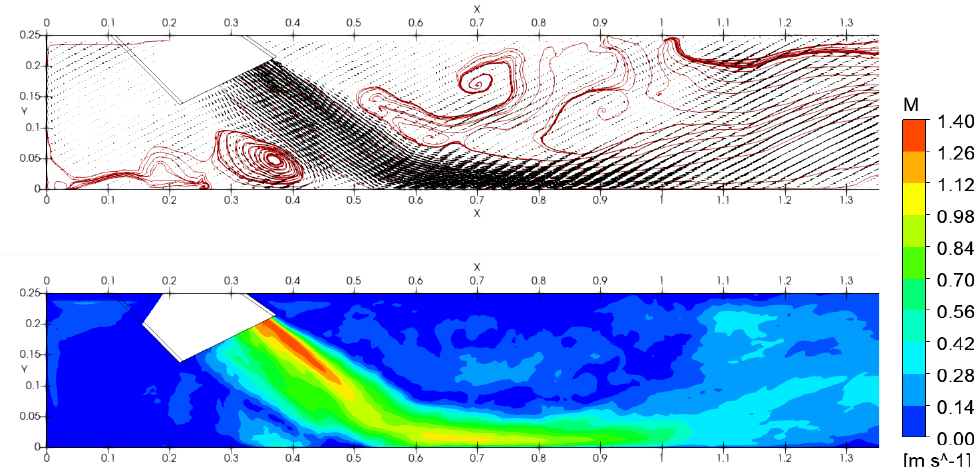
Figure 15. LBM, vector lines ( top ) and the magnitude of time-averaged 2D velocity ( bottom ) in vertical plane ( z = − 75mm ) .